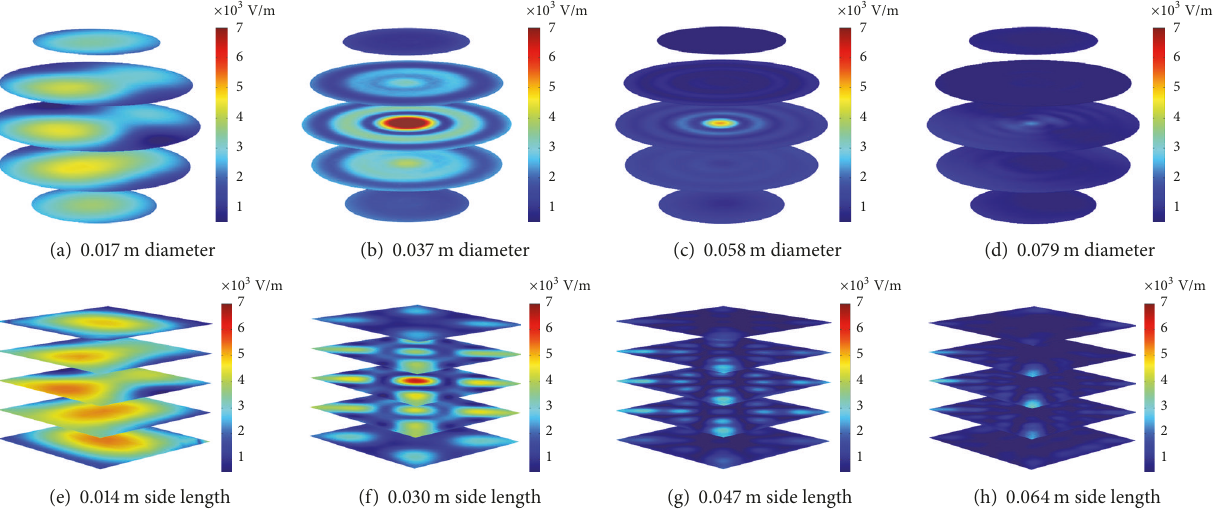
Figure 14: Spatial distribution of electromagnetic field in samples.